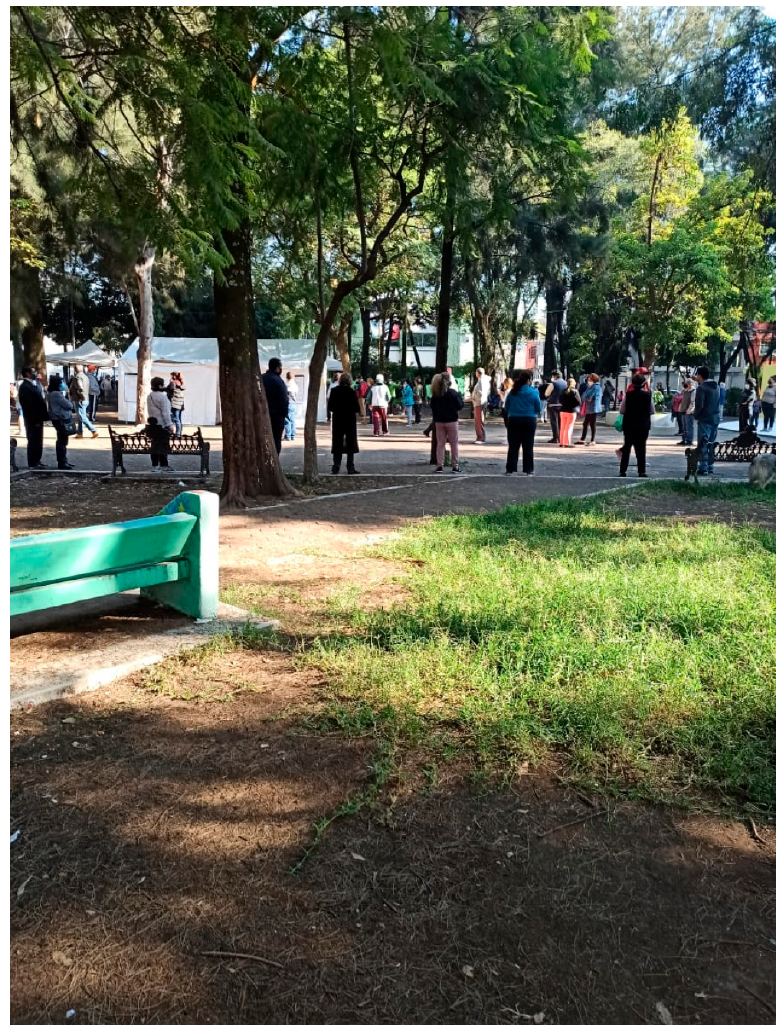
Figure 4. Testing center inside a park near Participant 11’s apartment complex.